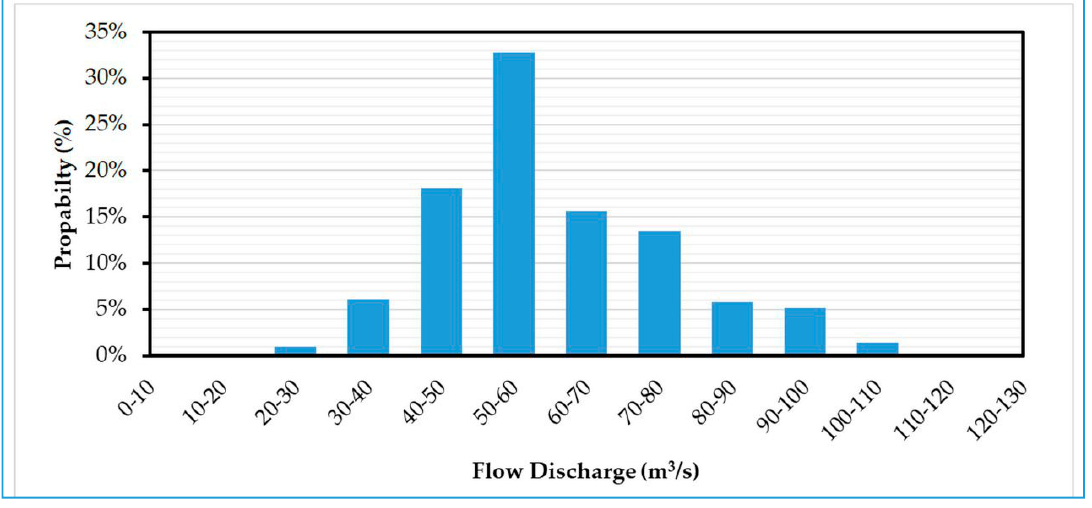
Figure 13. Discharge probability analysis.